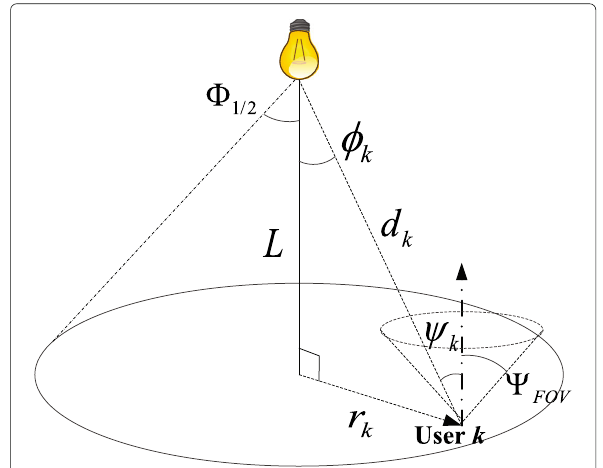
Fig. 1 VLC channel